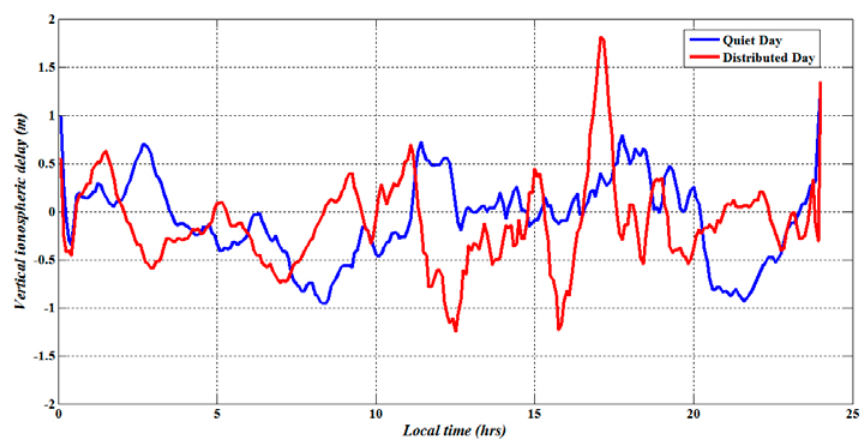
Fig. 3. Gradient of vertical Ionosphere delay towards East direction at IGP location (25° N , 75° E